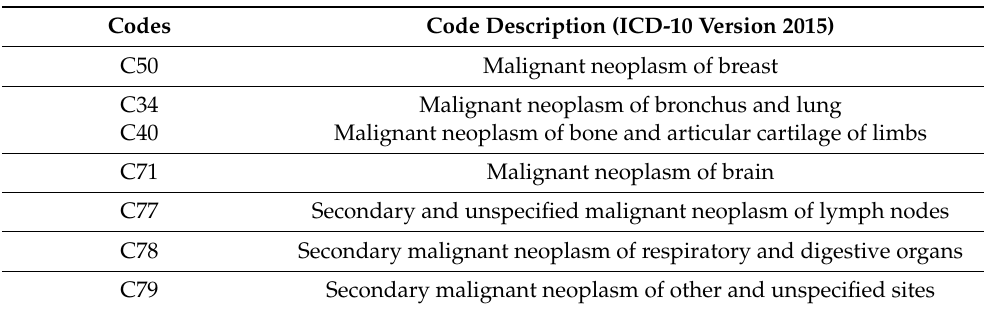
Table A7. International Classification of Diseases version 10 diagnosis codes that indicated a second breast cancer event.